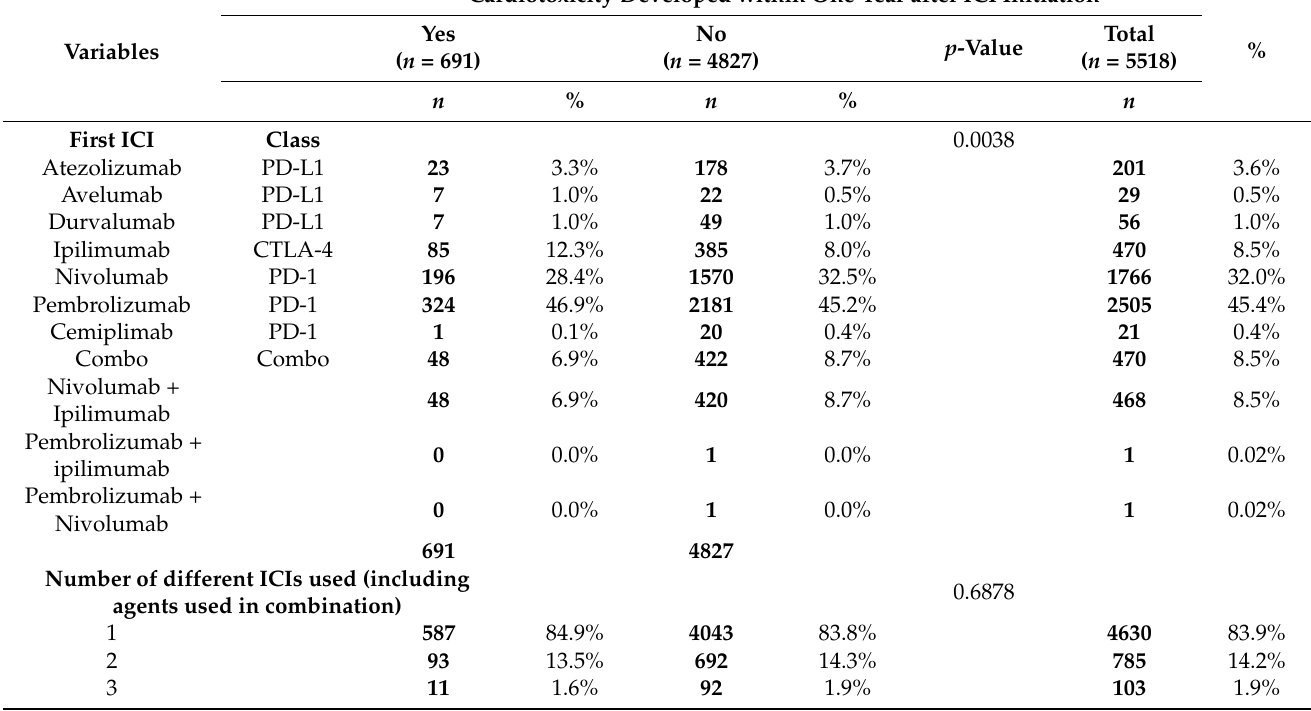
Table 2. First immune checkpoint inhibitor treatments.